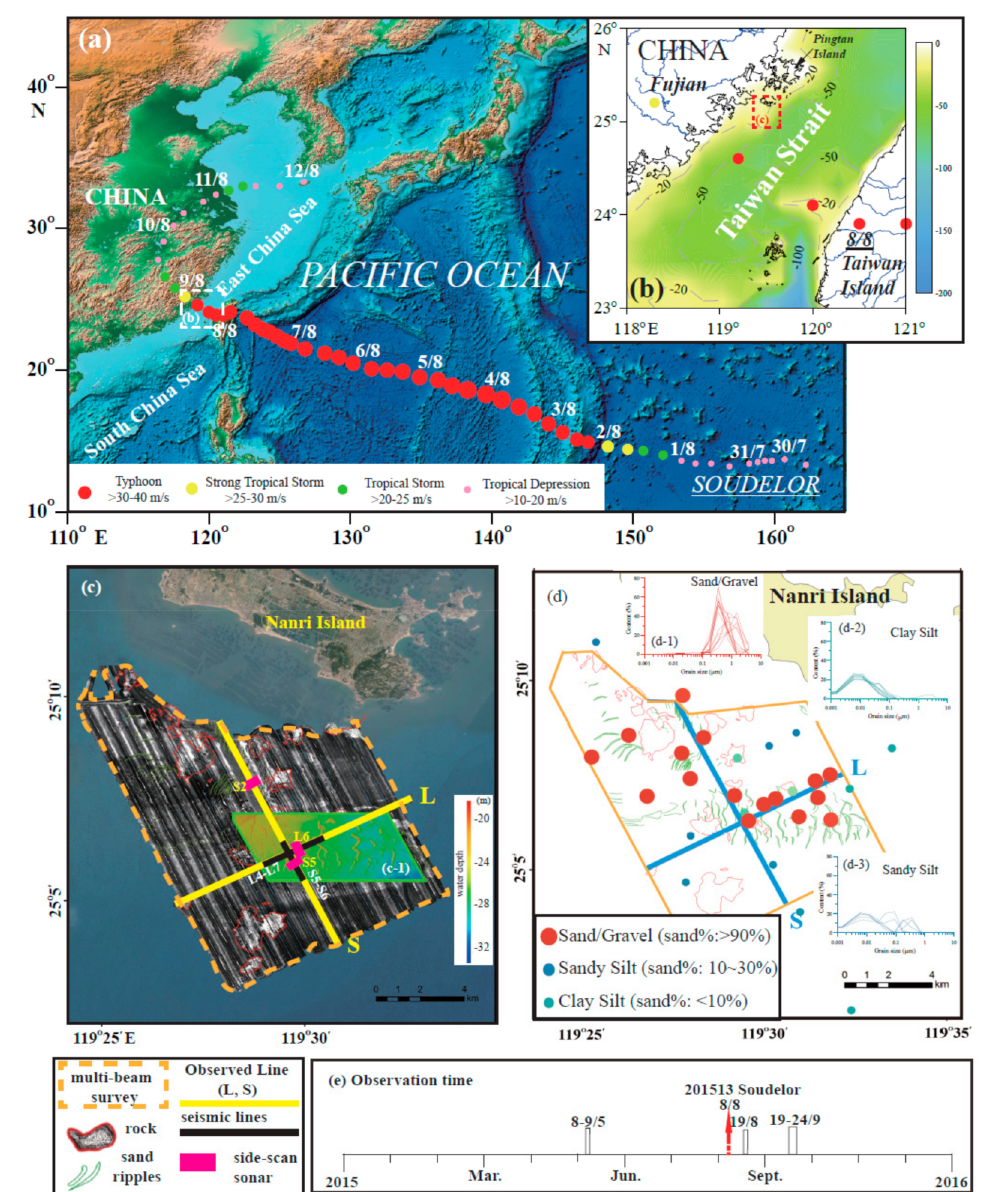
Figure 1. ( a ) The path of Typhoon Soudelor in 2015 (http: // agora.ex.nii.ac.jp / digital-typhoon / ); ( b ) study location in the Taiwan Strait; ( c ) submarine geomorphology of the study area observed using side-scan sonar and multibeam echosounder (c-1) and the observation lines with markers for L4–L7 and S5–S6, the seismic profiles in Figure 2 and with markers for S2, S5, and L6, the side-scan sonar profiles in Figure 3; ( d ) grain size distributions of the surface sediments for (d-1) sand / gravel, (d-2) sandy silt, and (d-3) clay silt; ( e ) the observation times of the three surveys and Typhoon Soudelor. Notice that the multibeam echosounder data was obtained in 2017. This figure was drawn using Surfer (version 11.6) (Golden Software LLC., Golden, CO,